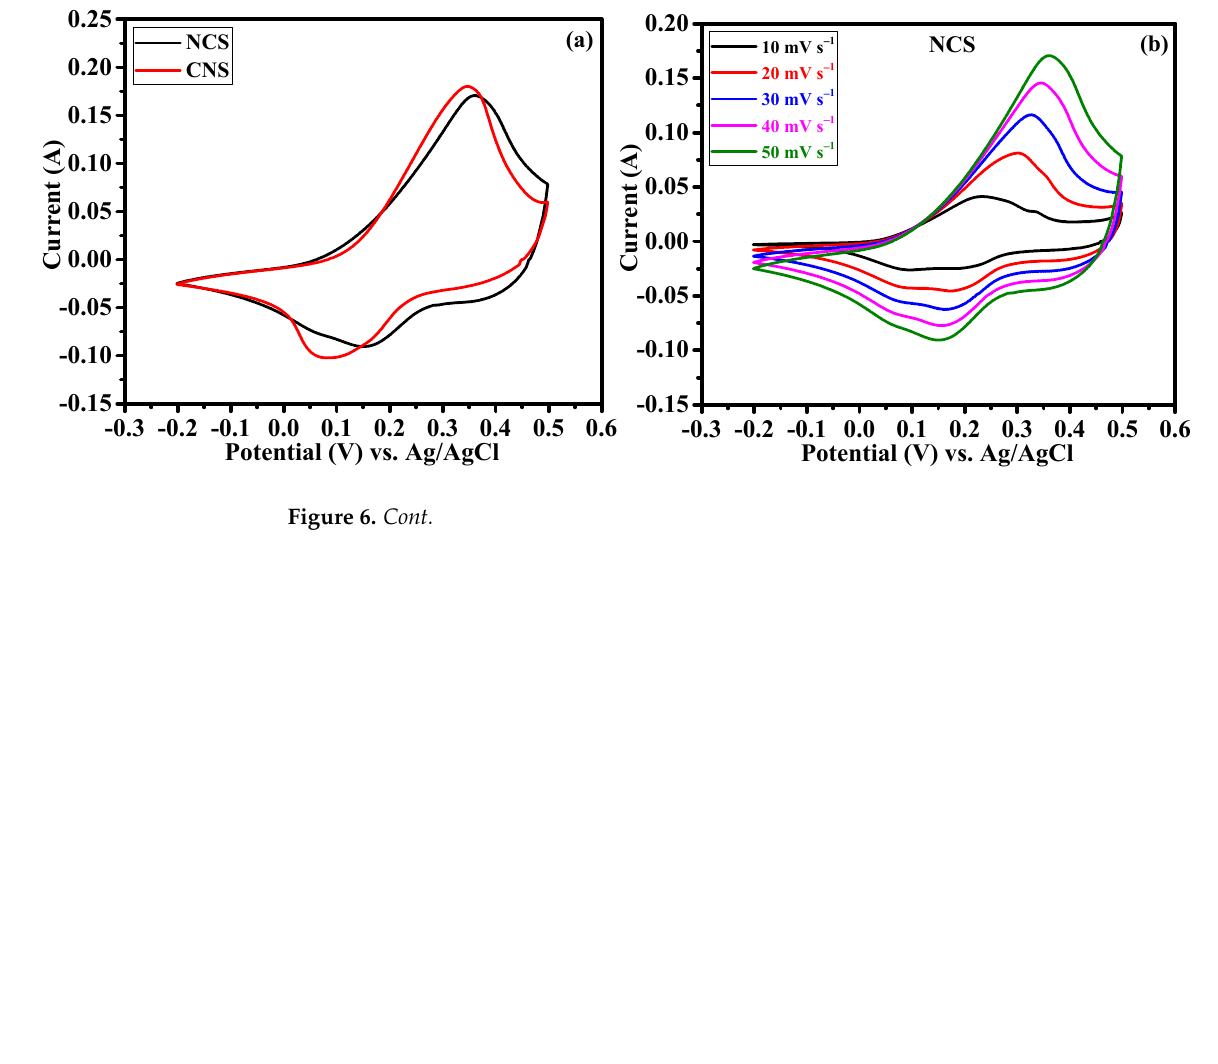
Figure 5. The intrinsic electrochemical properties of the as-prepared NCS and CNS electrodes. ( a ) Nyquist plots and the inset is equivalent circuit model and ( b ) plots of the current density differ- ences vs. the scan rate.